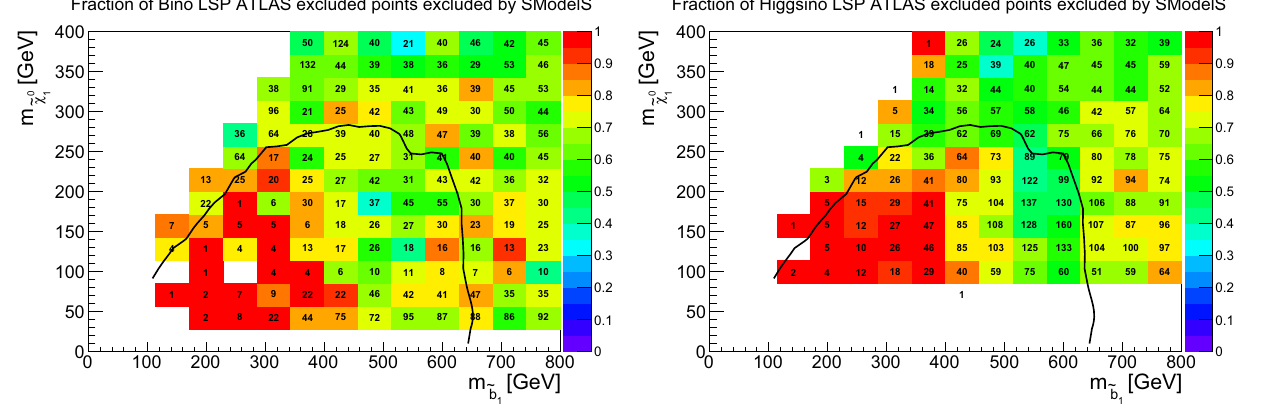
Fig. 9 Coverage in the sbottom vs. neutralino mass plane, for ˜ b 1 masses up to 800 GeV, for bino-like LSP scenarios (left) and higgsino- likeLSPscenarios(right).Thecolorcodeindicatesthefractionofpoints